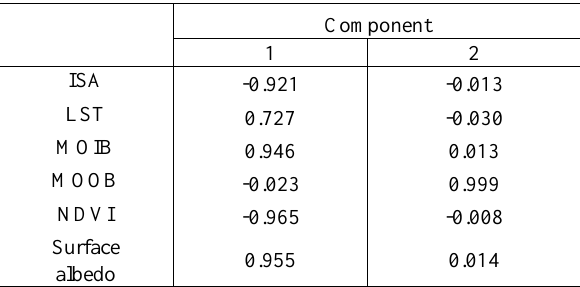
Table 3. The Component Matrix of all parameters in PCA